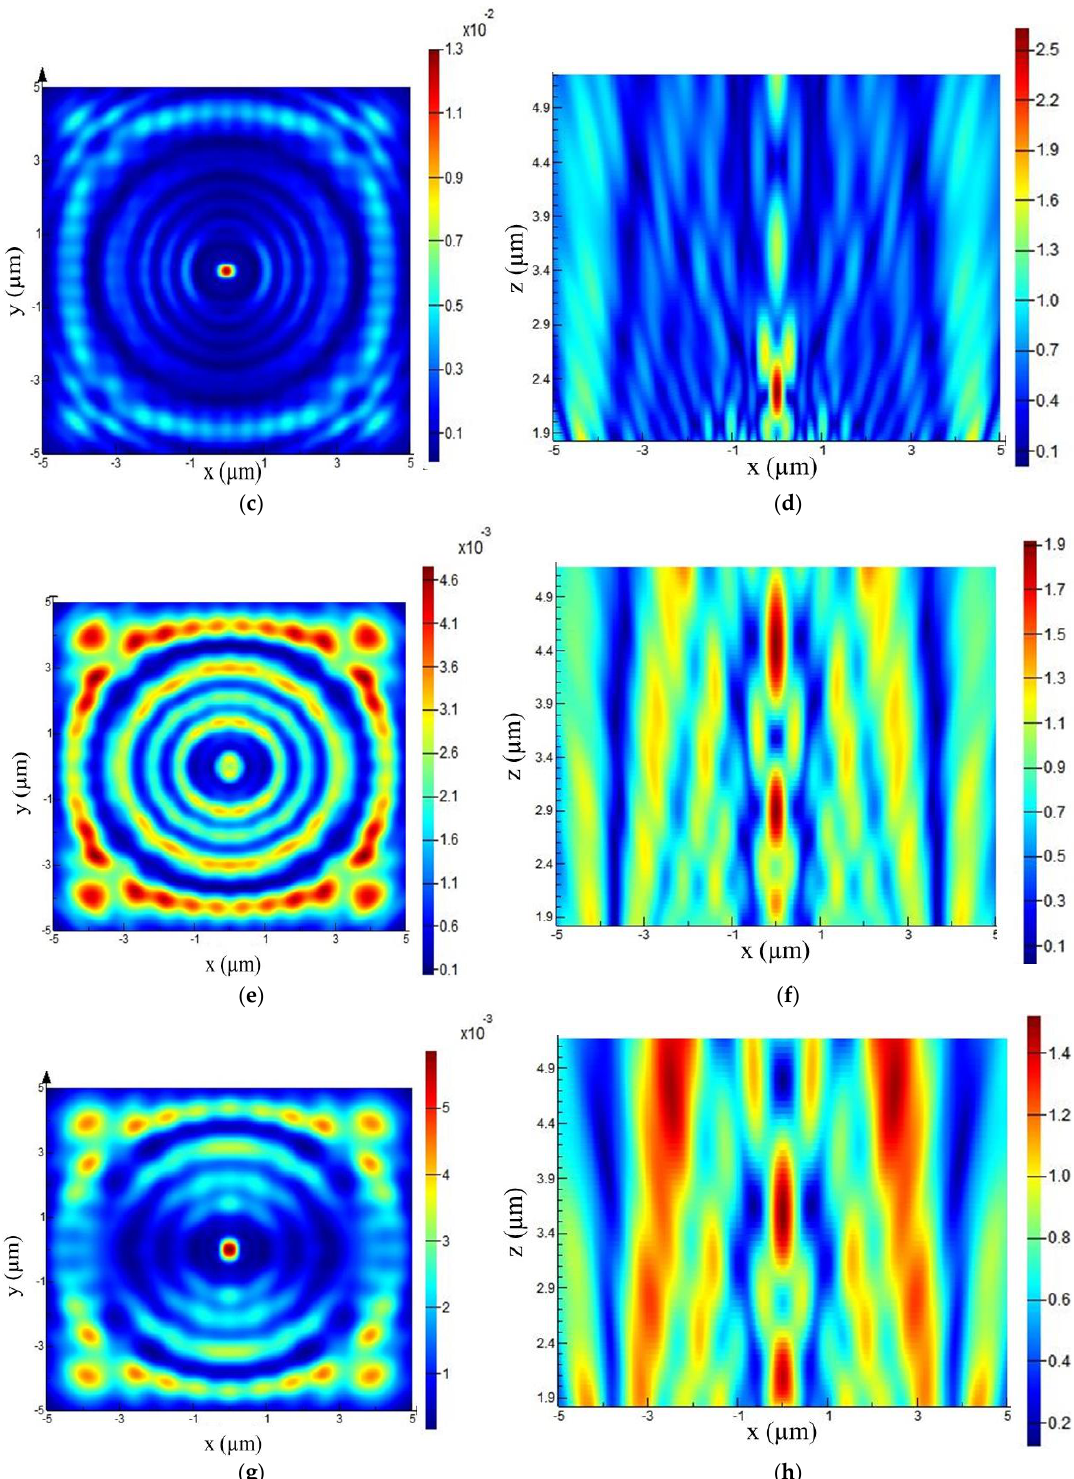
Figure 3. FDTD simulation of electric field distribution transmitted through in x-y plane view at calculated focal plane 650 nm above the exit plane ( left ) and electric field distribution at the x-z plane view at the center of the MRZ structure ( right ) for different wavelengths of ( a , b ) 420 nm, ( c , d ) 490 nm, ( e , f ) 625 nm, ( g , h ) 780 nm.